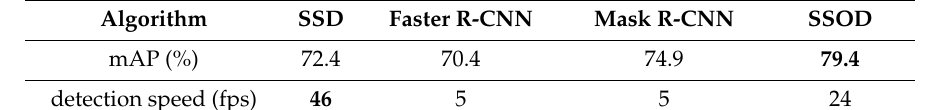
Table 3. Comparison of our algorithm and other state-of-the-art algorithms in terms of mAP values (%) and detection speed (fps) on the Pascal VOC 2012 dataset. The best accuracy or detection speed is shown in boldface.